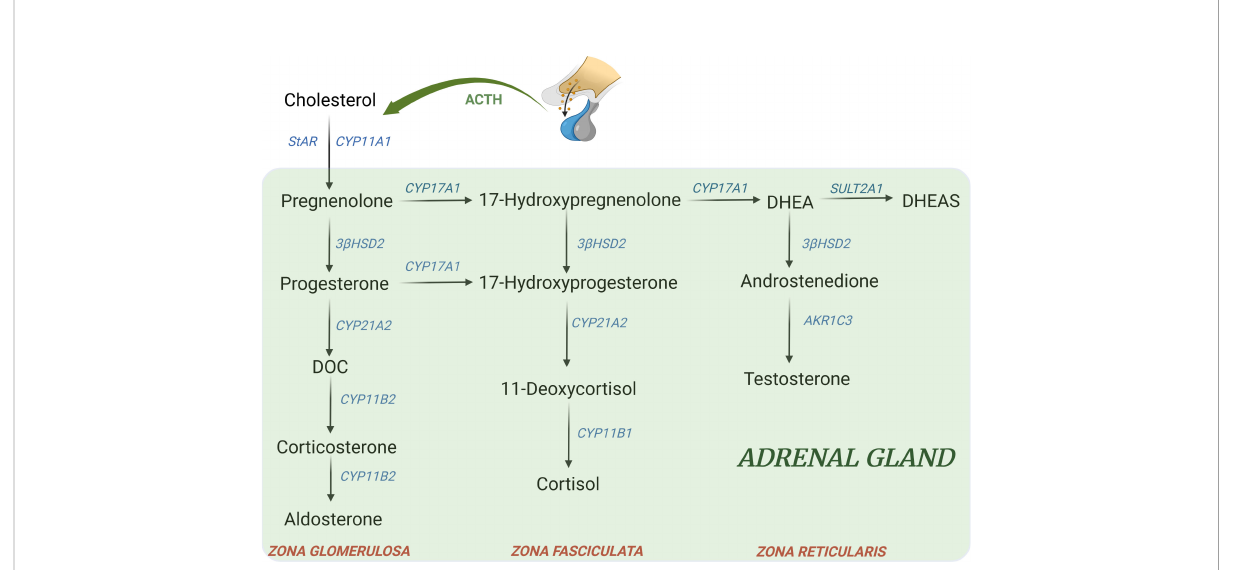
FIGURE 2 Major adrenal steroid synthesis pathways. Uncommon CAH forms include: - 11 b -hydroxylase de fi ciency (11-OHD): block at CYP11B1 → ↓ cortisol; ↑ DOC, ↑ 17-hydroxyprogesterone, androgens, ↑ 11-deoxycortisol - 17 a -hydroxylase de fi ciency (17-OHD): block at CYP17A1 → ↓ 17-hydroxyprogeserone, ↓ androgens; ↑ DOC, ↑ corticosterone - 3 b -hydroxysteroid dehydrogenase type II de fi ciency (3 b -HSD): block at 3 b -HSD → ↓ aldosterone, ↓ androgens in male; ↑ 17hydroxypregnenolone, ↑ 17-hydroxyprogesterone, ↑ DHEA - Lipoid form (LCAH) → block at StAR level → ↓ all steroids - P450 oxidoreductase de fi ciency (PORD): multiple partial blocks of CYP17A1 and CYP21A2 → ↓ androgens; ↑ progesterone, ↑ 17-hydroxyprogesterone, ↑ corticosterone (74). DOC, 11-deoxycorticosterone; DHEA, dehydroepiandrosterone; DHEAS, dehydroepiandrosterone